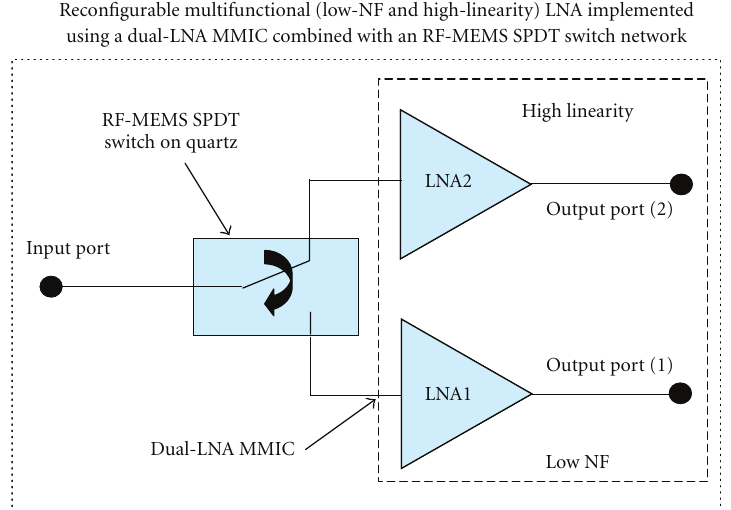
Figure 1: Schematic of an RF-MEMS enabled reconfigurable and multifunctional (low-NF and high-linearity) dual-path LNA (with LNA circuit functions denoted as LNA1 and LNA2, resp.).